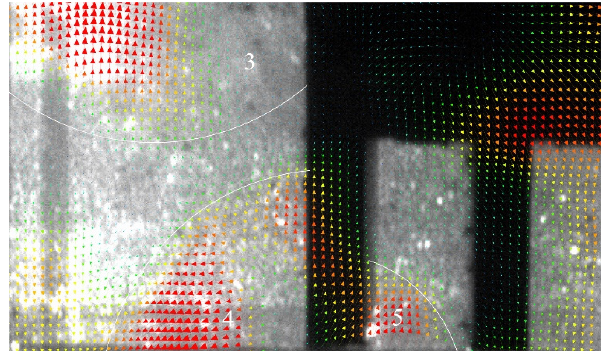
Figure 11. Vector diagram of soil displacement for MN-15 model.